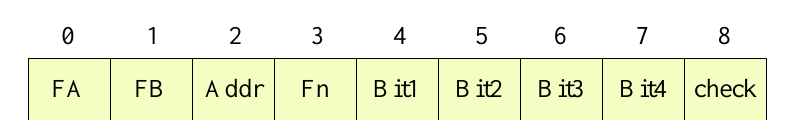
Table 4. Wireless data communication protocol.